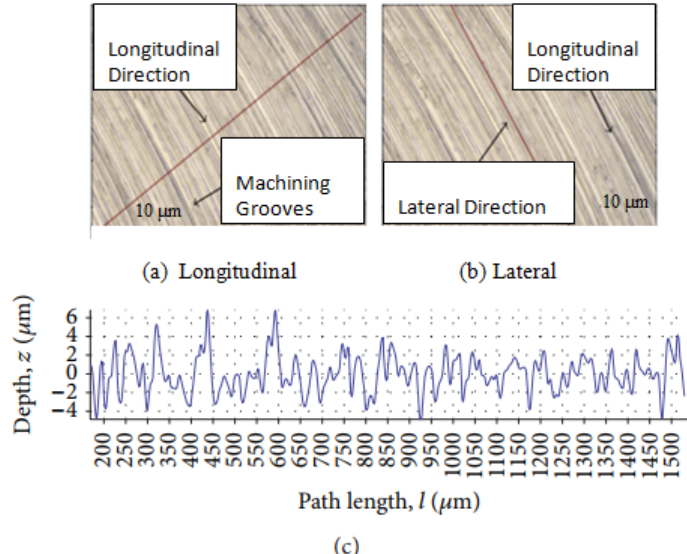
Figure 7. Measurement of surface roughness in ( a ) longitudinal direction, ( b ) lateral direction and ( c ) representation of path length.